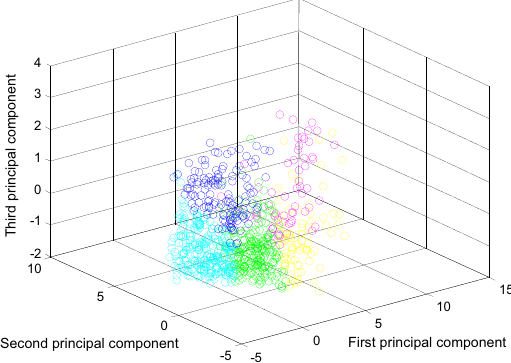
Figure 9. The distribution of the clustering samples using ISODATA in the first three principal components space.